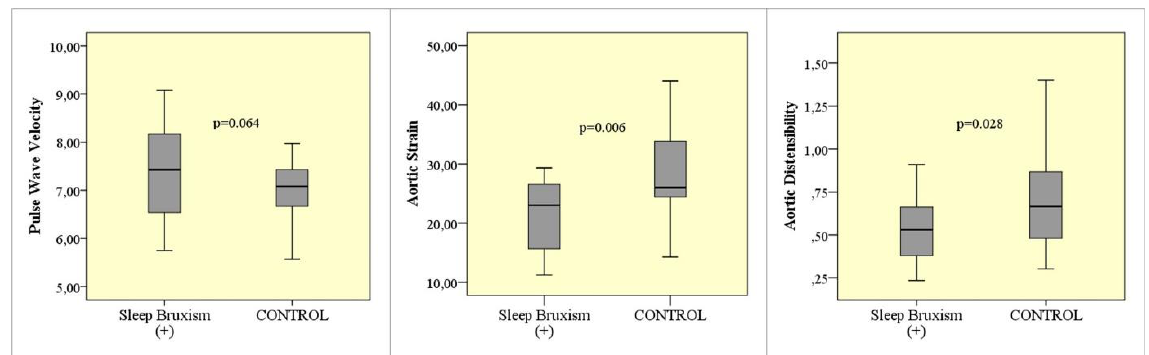
Fig. 1. Comparison of aortic strain, distensibility, and PWV of Sleep Bruxism (+) subjects and control group by box plots.